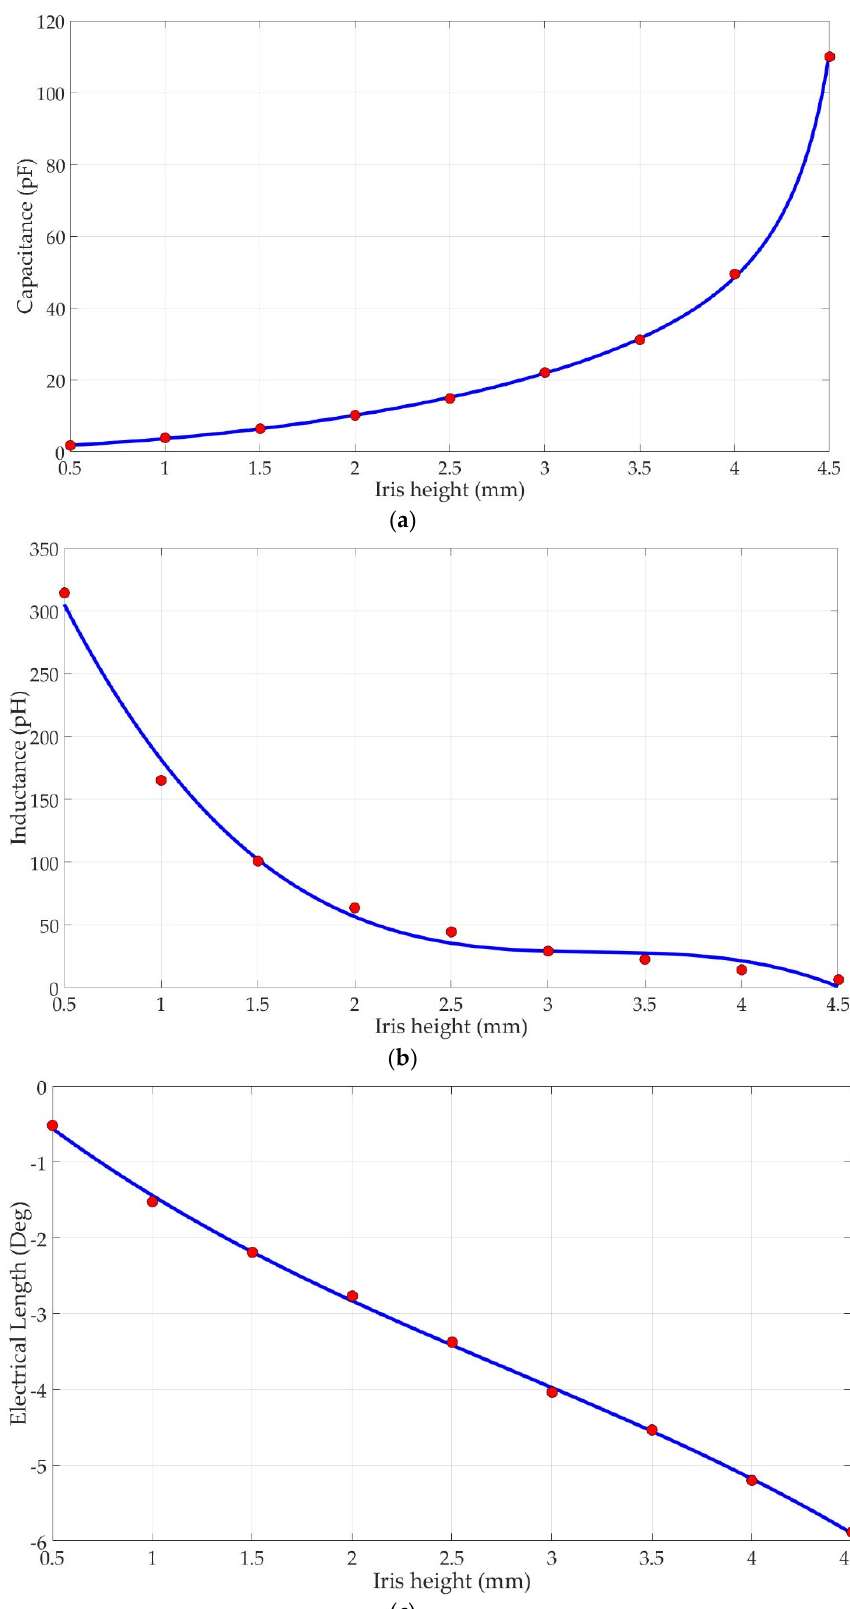
Figure 6. Fitting values (red dots) and polynomial interpolation (solid line) for the circuit element parameters. ( a ) C ; ( b ) L ; ( c ) θ.